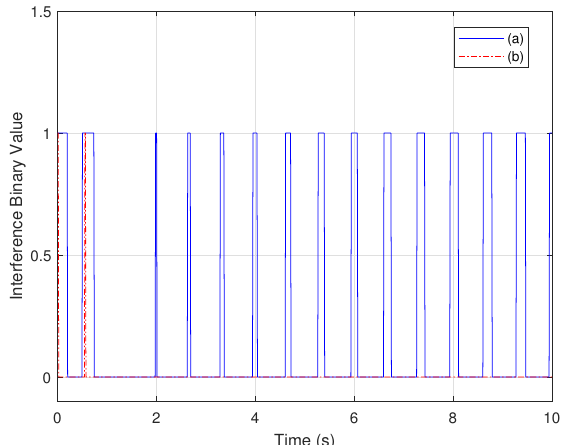
Figure 8. gPC-based observability Gramian analysis interference binary value: (a) large noise variance and (b) small noise variance.